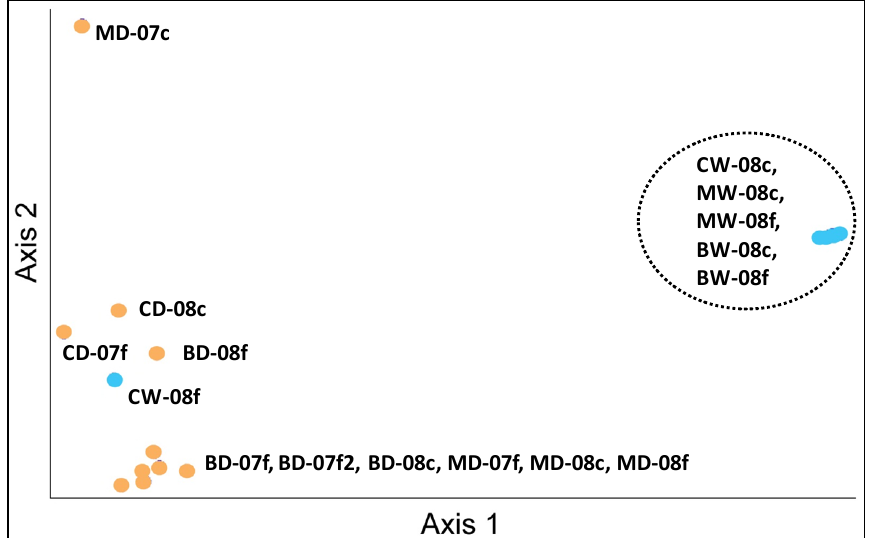
Figure 6. Axis 1 vs . 2 Principle Component Analysis for sediment analyzed from T-RFLP analyses. Samples were clustered on the basis of the OTU data. Sample IDs correspond to the naming convention in Table 1. Orange circles = drier period; Blue = wetter period (M = Marks Creek, B = Bear Creek, C = Crabtree Creek, W = wet; D = dry. Numeric code is the year of collection. Lower case letters depict sediment size; c= coarse; f =